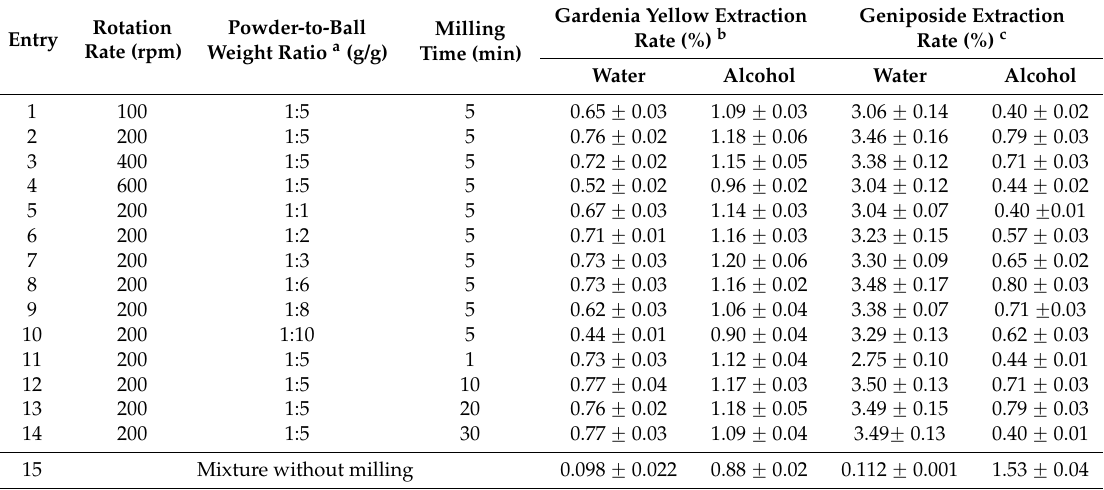
Table 1. The influence of rotation rate, milling time and powder-to-ball weight